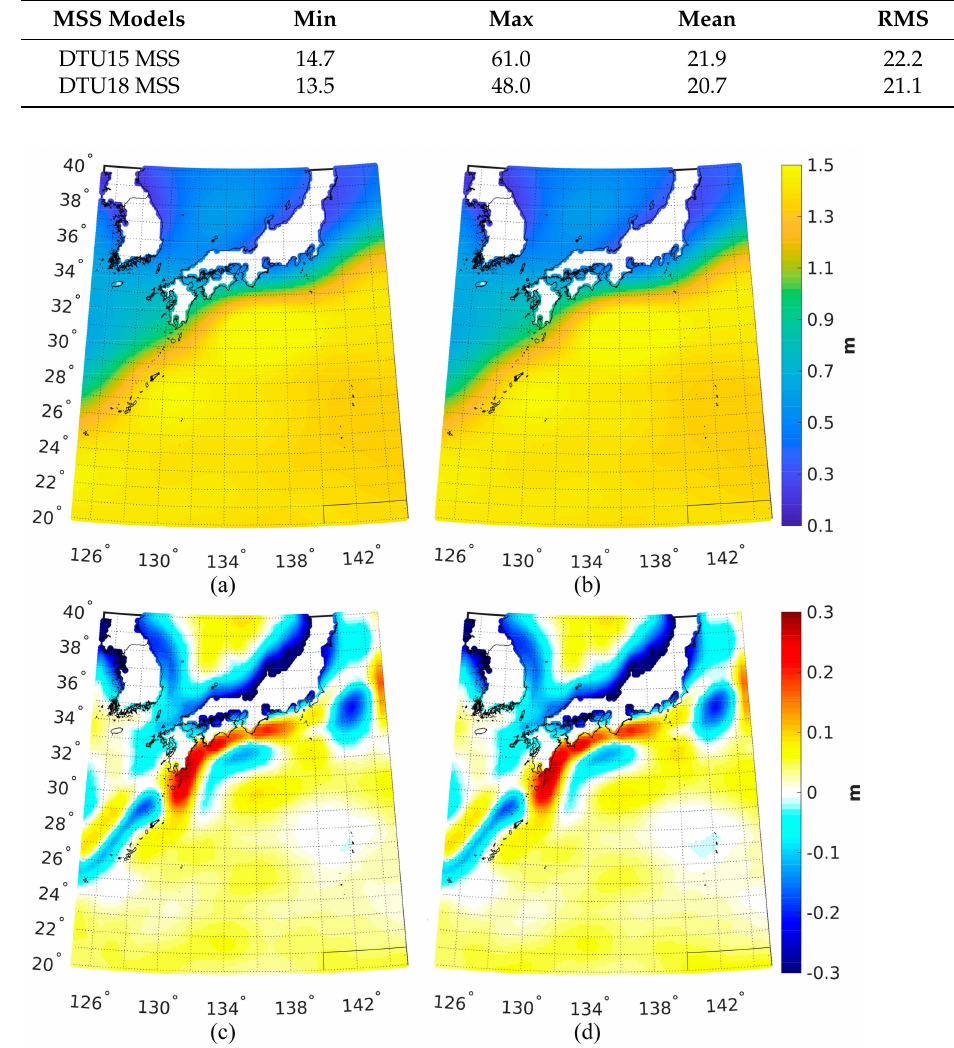
Table 6. Statistics of the errors of the MSS models (units: mm).